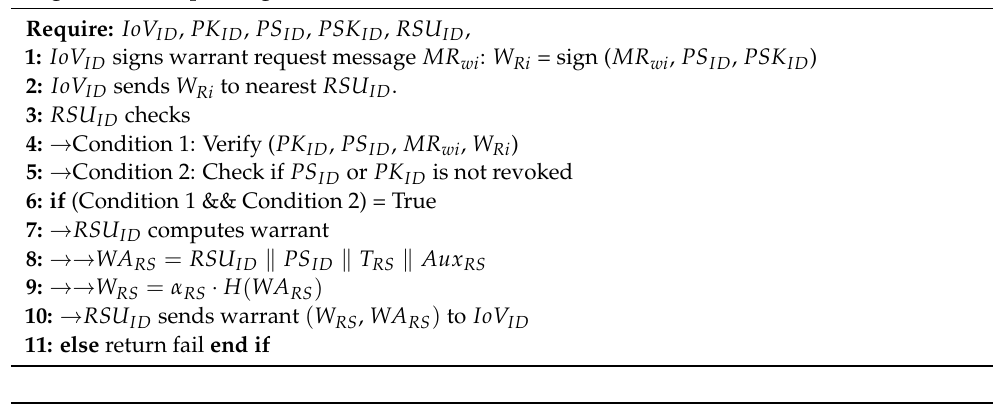
Algorithm 2: Creating Transaction for Data Generated